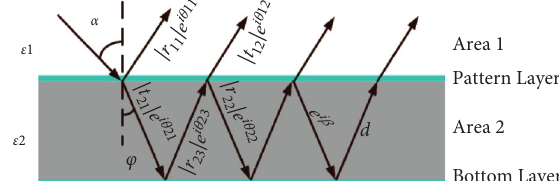
Figure 17: Theoretical model of multiple reflection with vertical and oblique